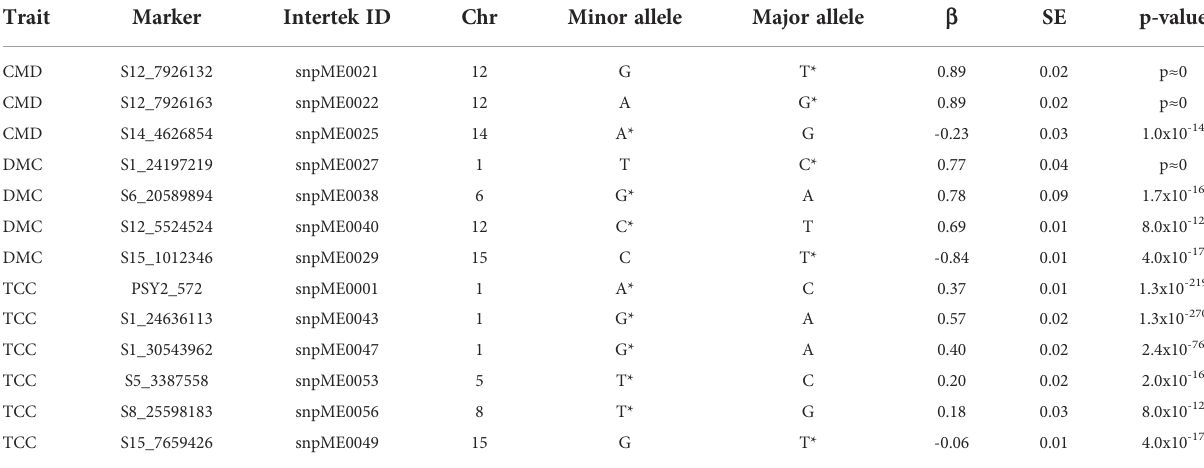
TABLE 1 Summary statistics of 13 KASP markers validated for CMD, DMC and TCC.